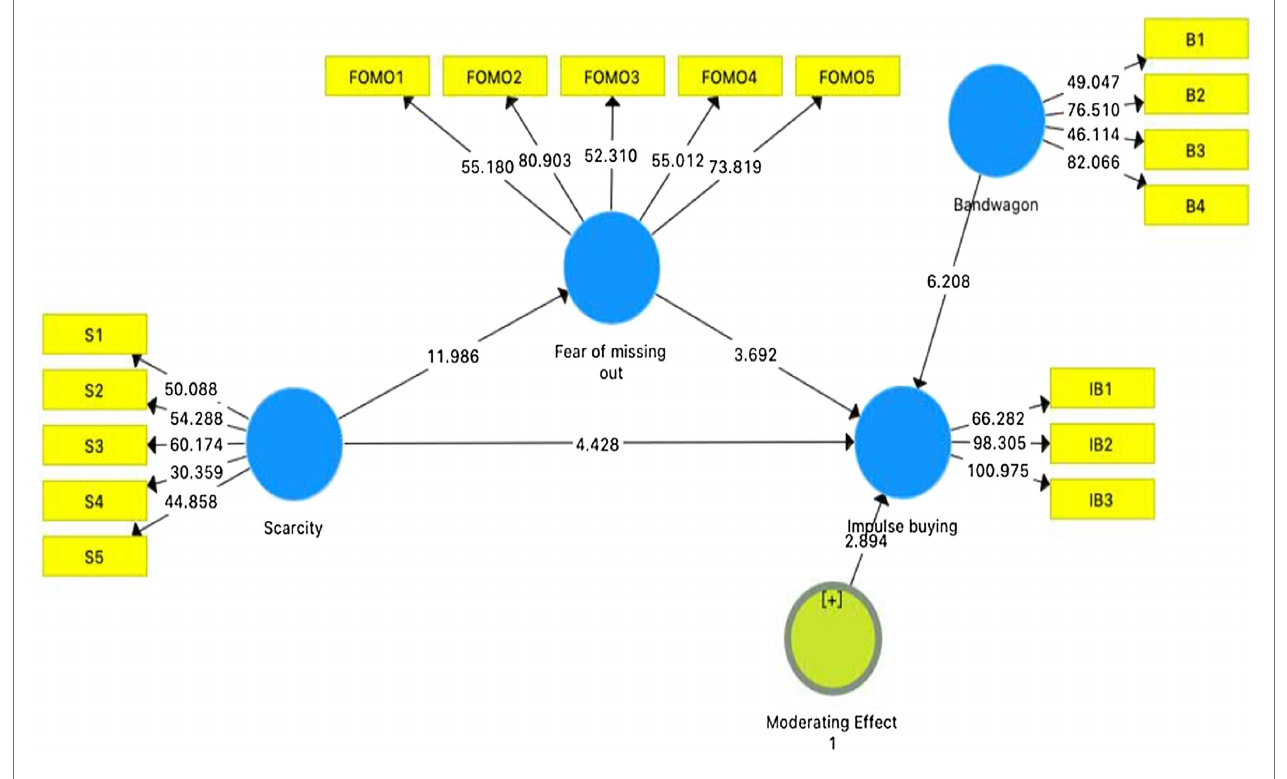
FIGURE 2 | The results of the structural